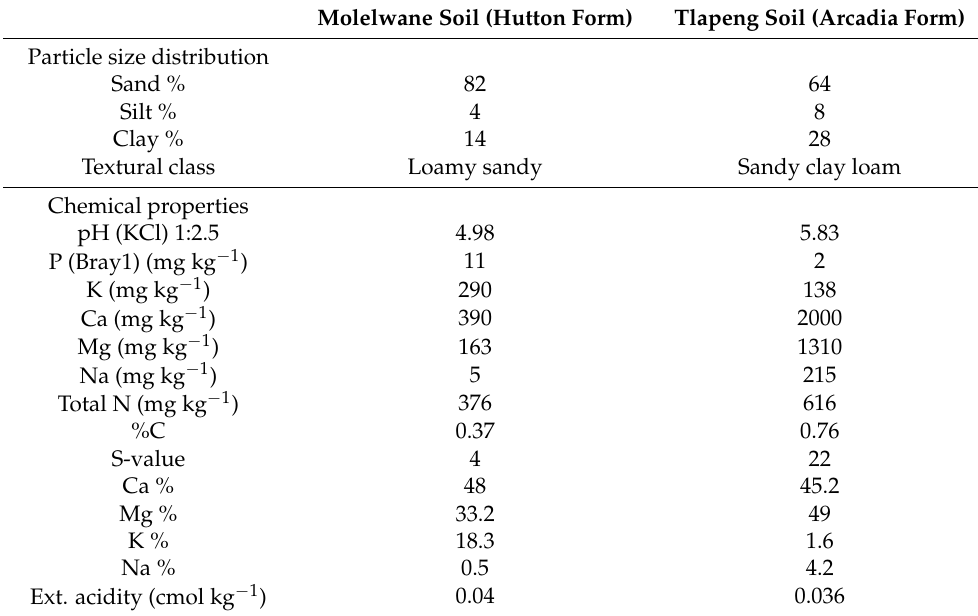
Table A1. Physical and chemical properties of the two soil